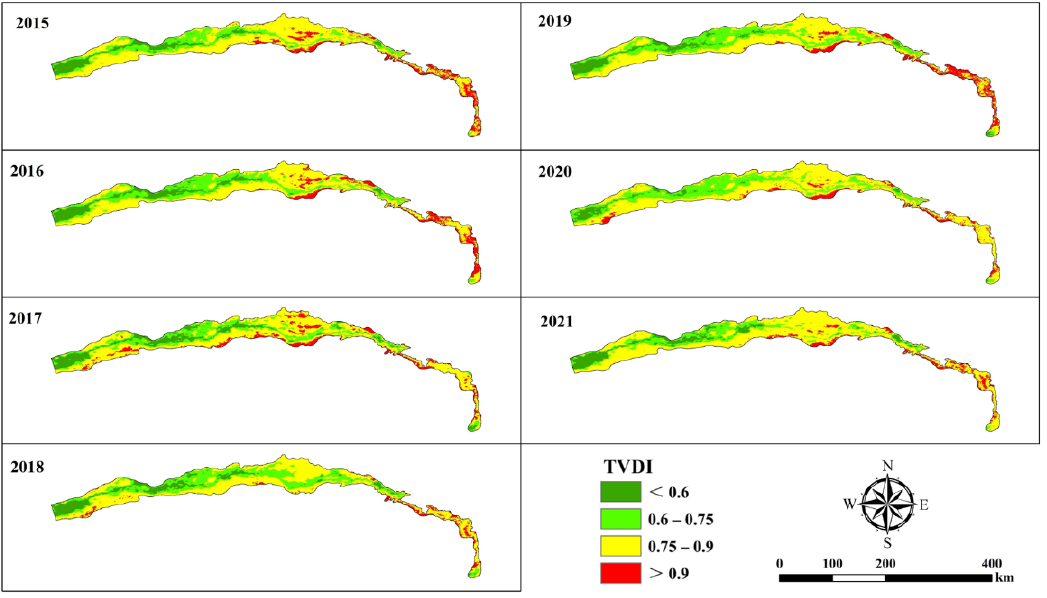
Figure 4. Spatial distribution of TVDI grades in the mainstream area of the Tarim River from 2015 to 2021.